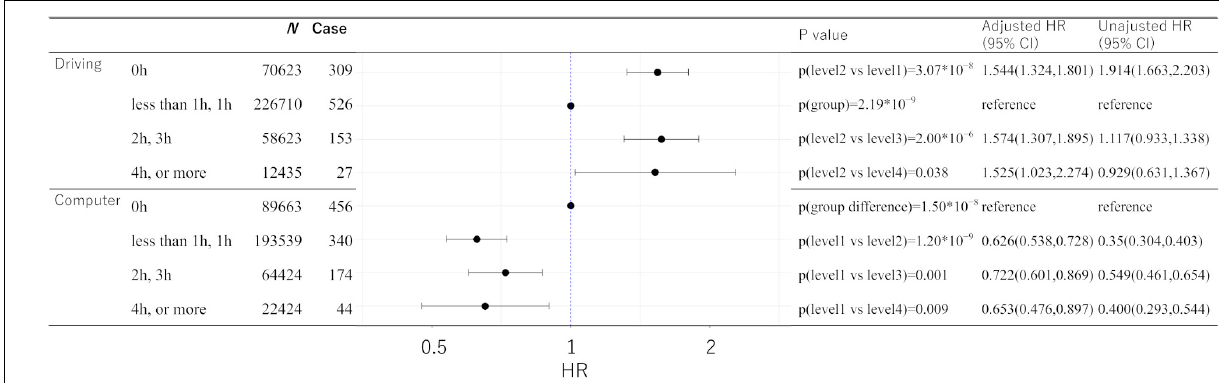
FIGURE 4 | Statistical values and hazard ratios (95% CIs) for the associations between driving length, non-occupational computer use length, and incident dementia for more than 5 years after baseline in the UK Biobank data. Participants are categorized according to the length level at the baseline. “ p (group)” indicates the p -values of the existence of the group difference among all the groups. 95% CI, 95% confidence interval; HR, hazard